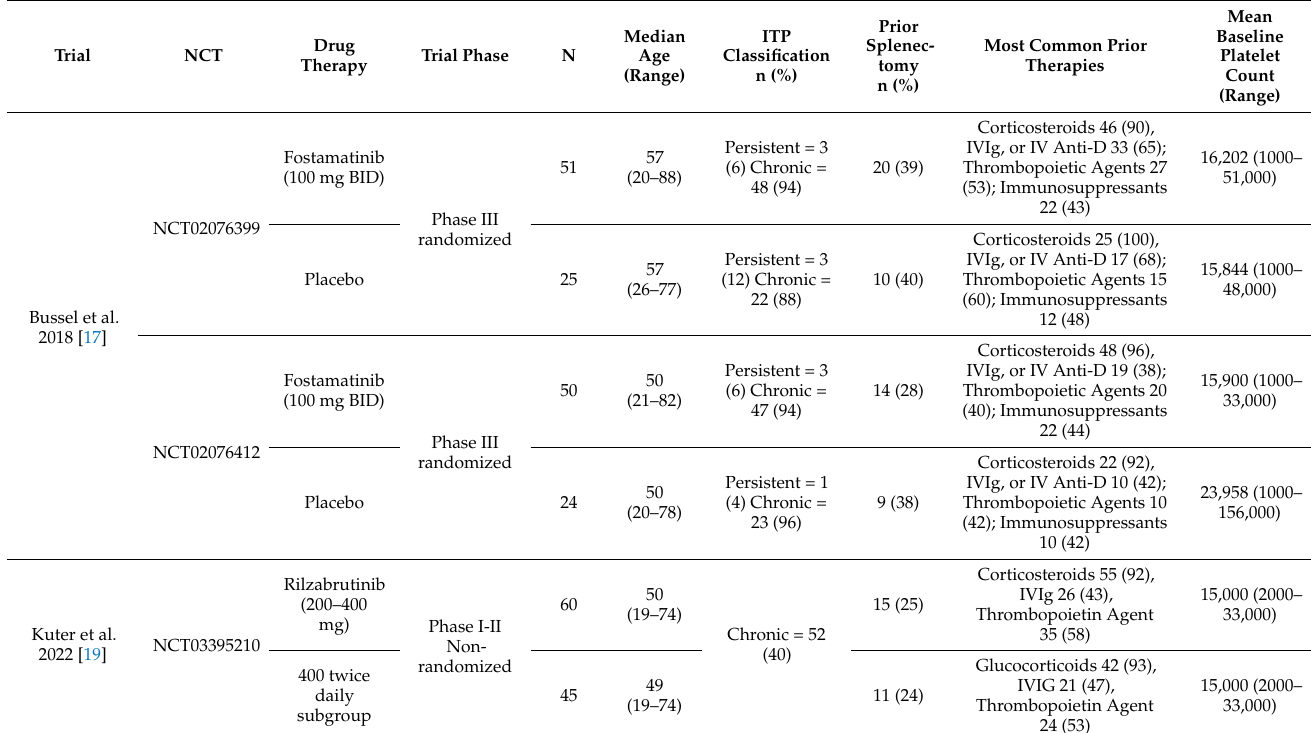
Table 1. Baseline characteristics of patients in included clinical trials.